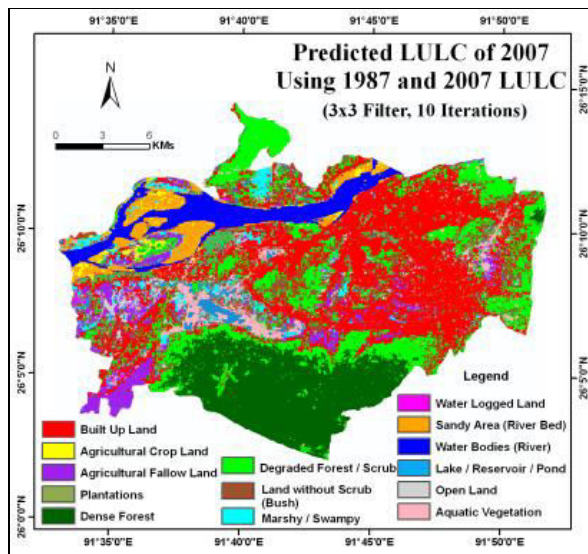
Figure 7. Predicted LULC of 2007 using 1987 & 1997 LULC image (3x3 contiguity filter, 10 iterations)